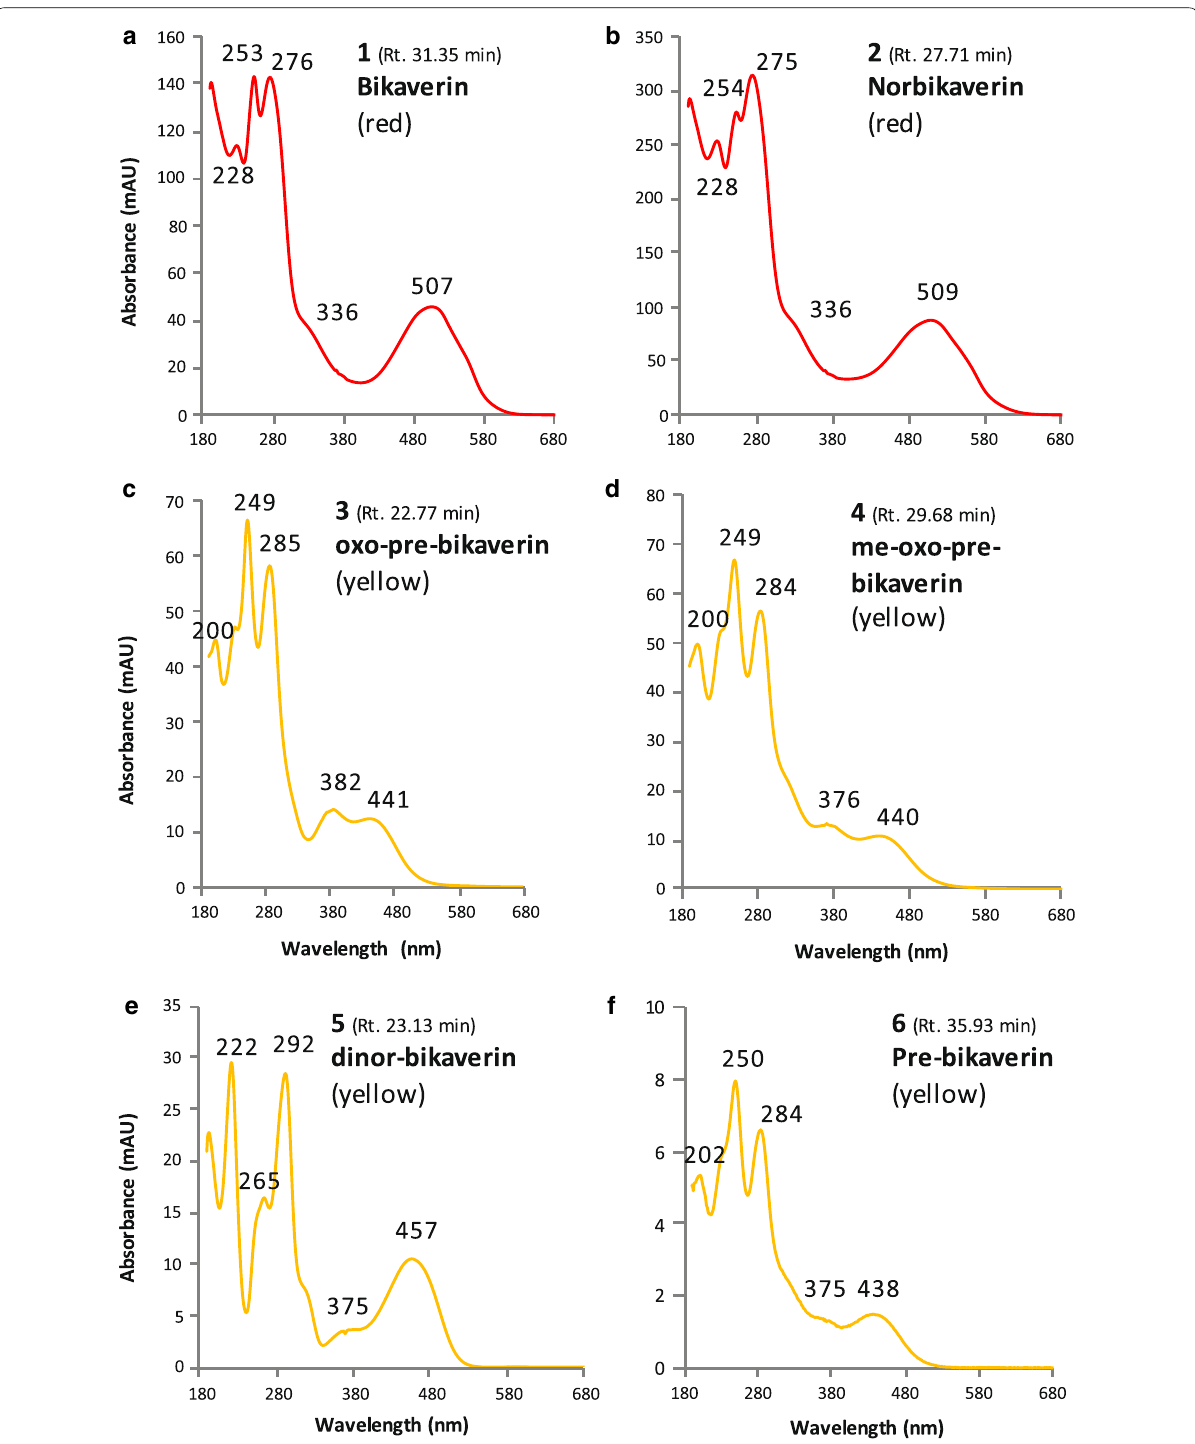
Fig. 4 Absorbance spectra of the naphthoquinone pigments a bikaverin 1 and bikaverin intermediates: b norbikaverin 2 , c oxo-pre-bikaverin 3 , d me-oxo-pre-bikaverin 4 , e dinor-bikaverin 5 , and f pre-bikaverin 6 , isolated in intracellular extracts of F. oxysporum LCP531. Numbers and retention time (Rt.; in min.) are referring to the compounds identified on Figs. 2 and 3. Colors on graphs are referring to the red or yellow pigments isolated and identified in this